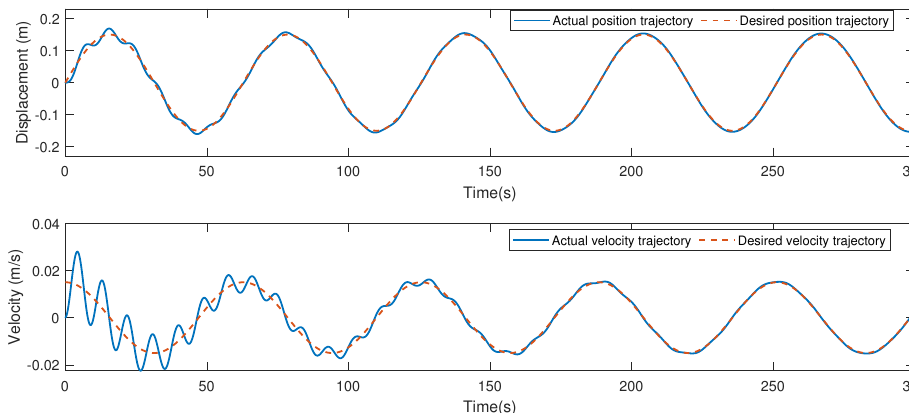
Figure 10. The position and velocity trajectory of the robot.